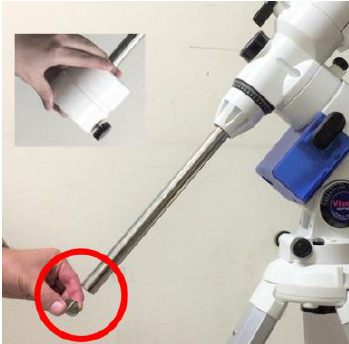
Figure 2. Thumbscrew of the counterweight